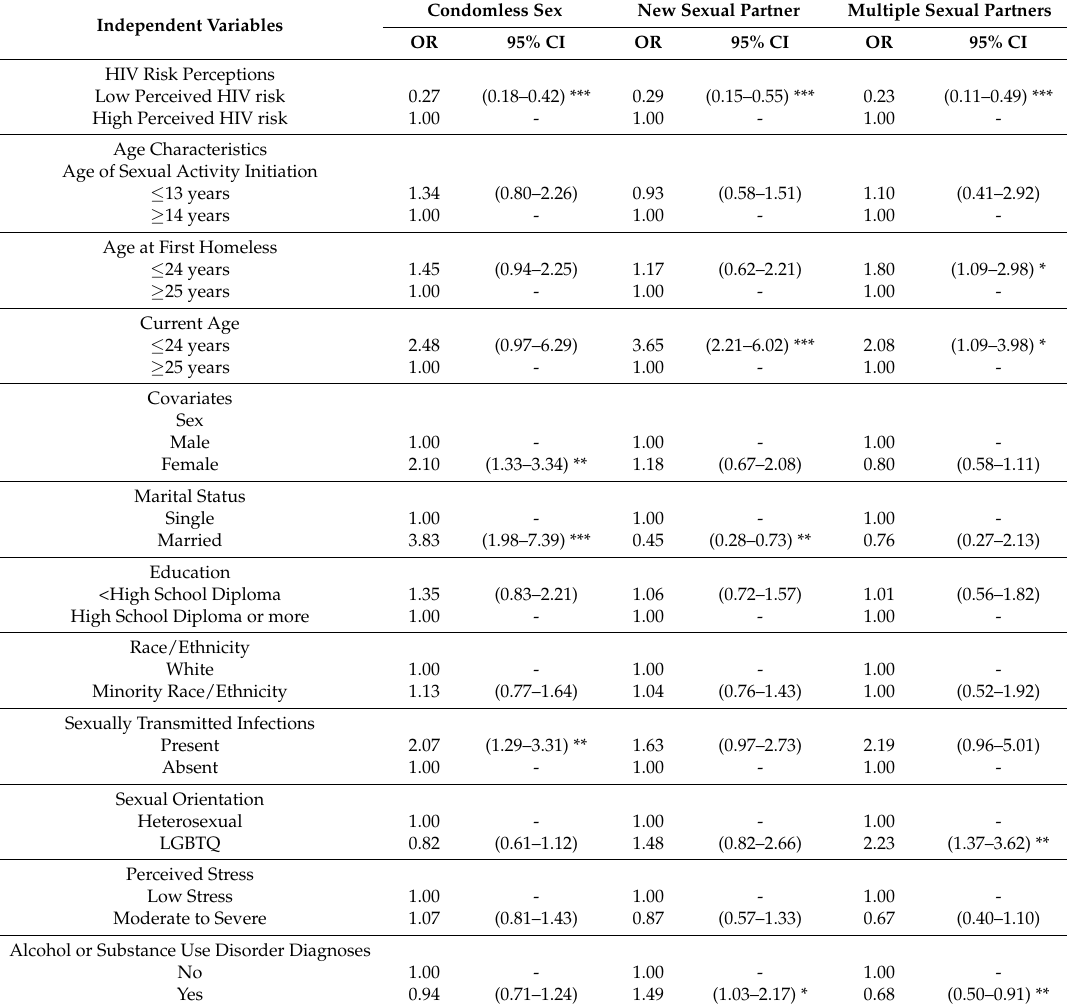
Table 2. Ordinary Least Squares Regression Models Predicting Past Year Sexual Risk Behaviors among Homeless Adults ( n =